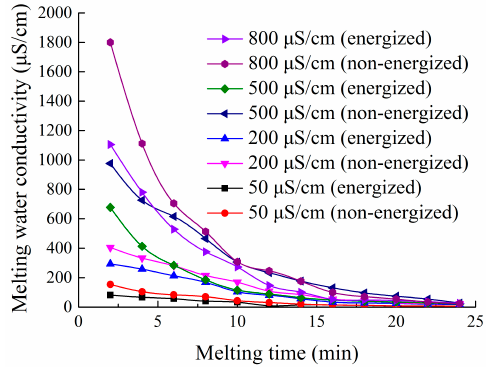
Figure 7. Variation of the melting water conductivity of icicle.